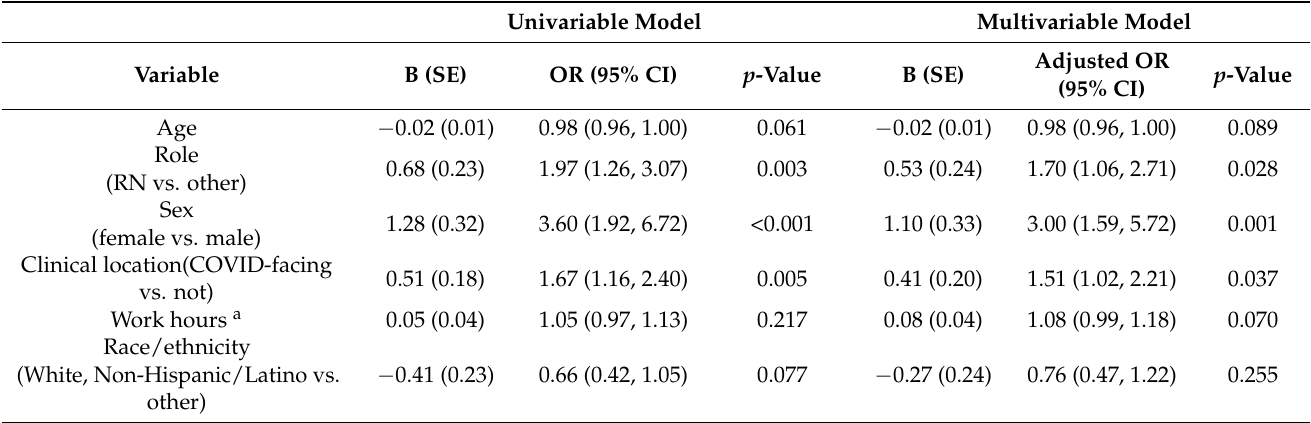
Table 2. Generalized estimating equation (GEE) univariable and multivariable models to identify factors associated with PC-PTSD score ≥ 3 at 10-week